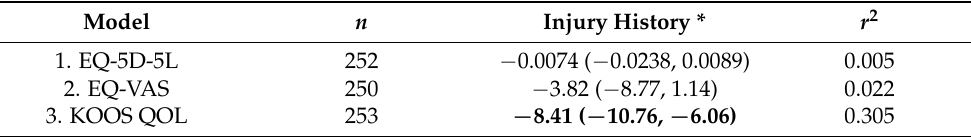
Values represent coefficient and 95%CI. All models accounted for clustering by sex and sport. Bolded font repre- sents 95%CI does not encompass zero. * Reference = uninjured participants. EQ-5D-5L, EuroQoL